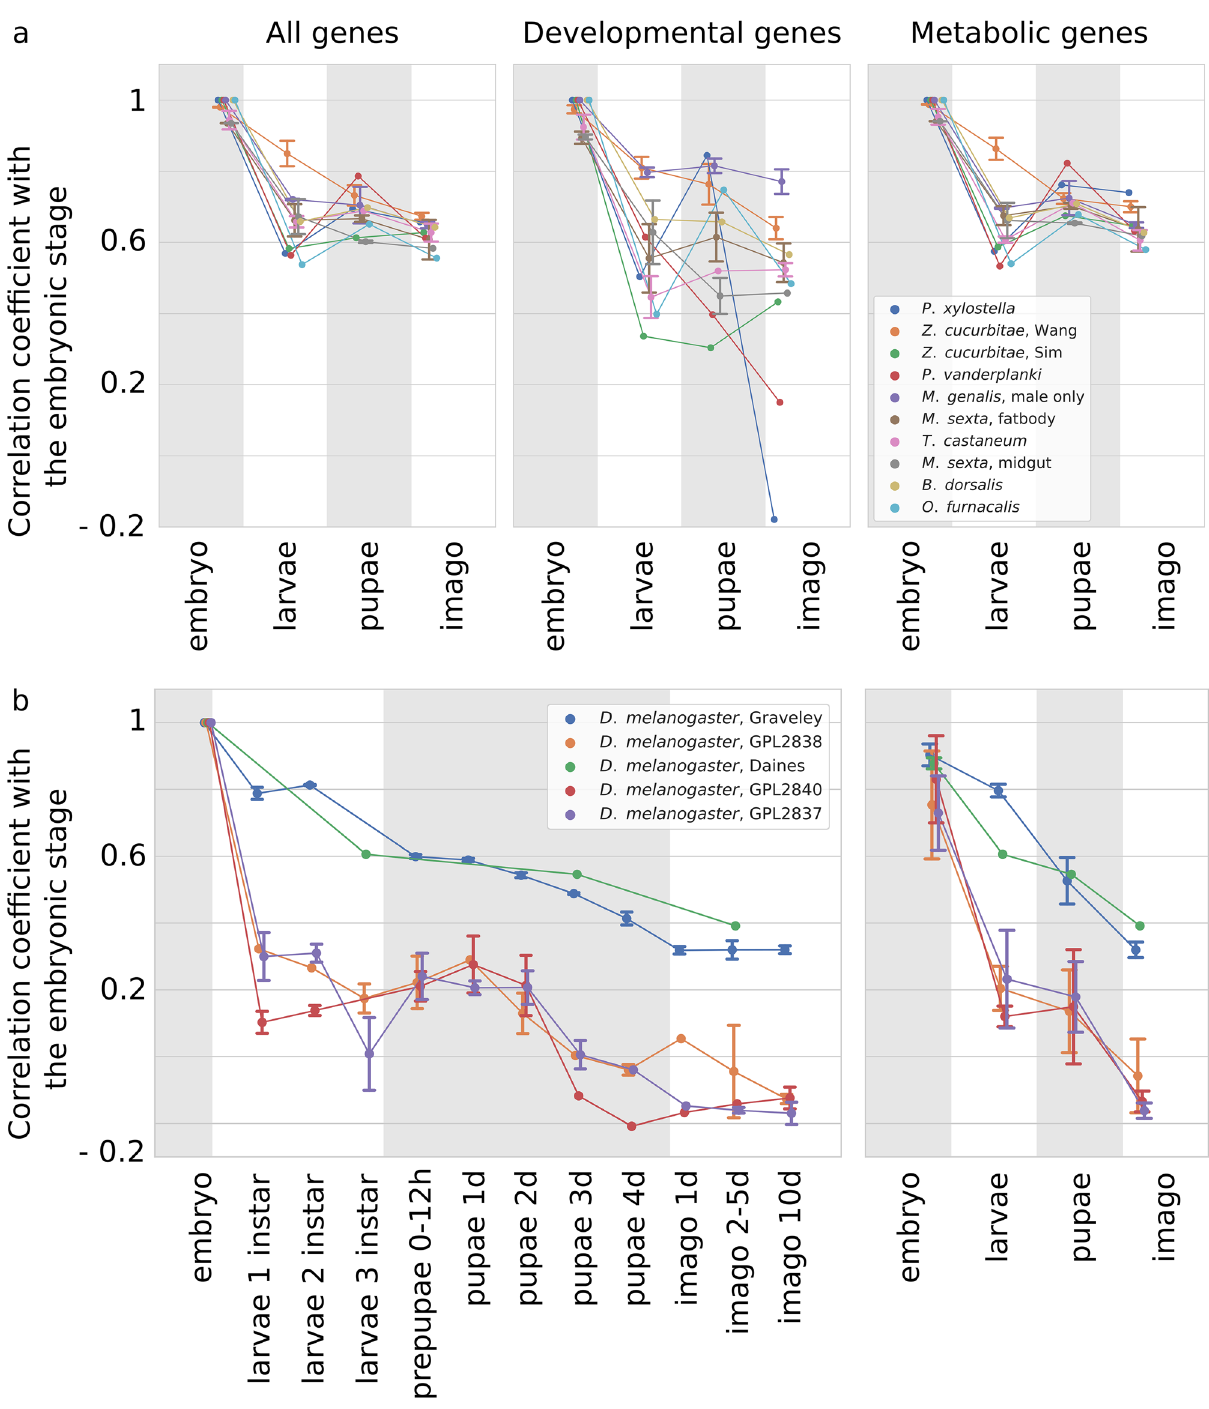
Figure 3. Similarity with the embryonic transcriptional profile. Sequential stages of development are shown on the horizontal axis, the correlation with the embryonic state is shown in the vertical axis. Quartiles are shown for datasets with available replicates. The color of the lines reflects the source dataset, see the legend insert. ( a ) Correlation coefficients for all genes (left), development-associated gene subset (middle) and metabolism- associated gene subset (right) for all species excluding D. melanogaster . ( b ) Correlation coefficients for all genes for D. melanogaster datasets for the detailed data (left) and averaged across the four major stages